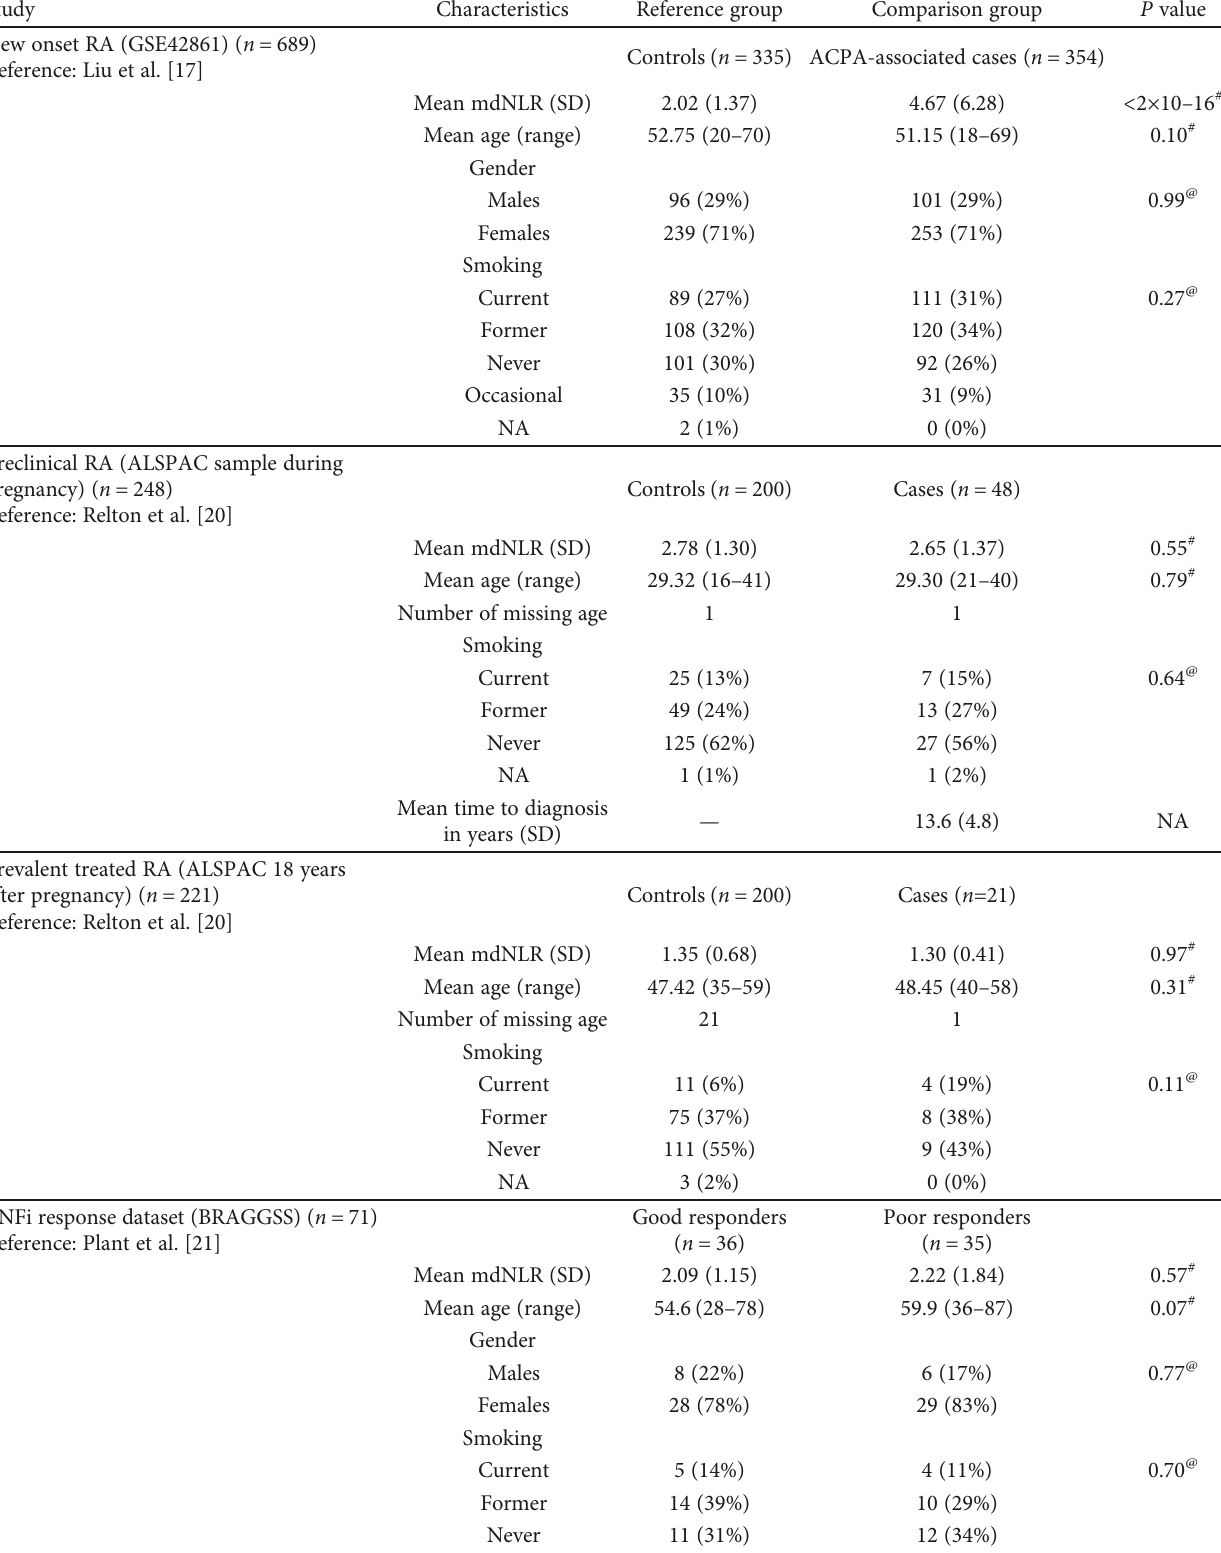
Table 1: Sample characteristics of